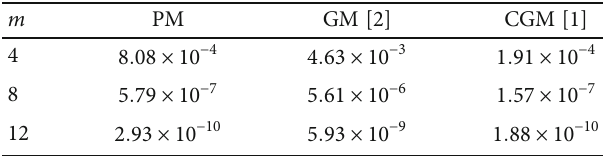
Table 1: Maximum absolute errors for Example 1 at di ff erent degrees of approximation m